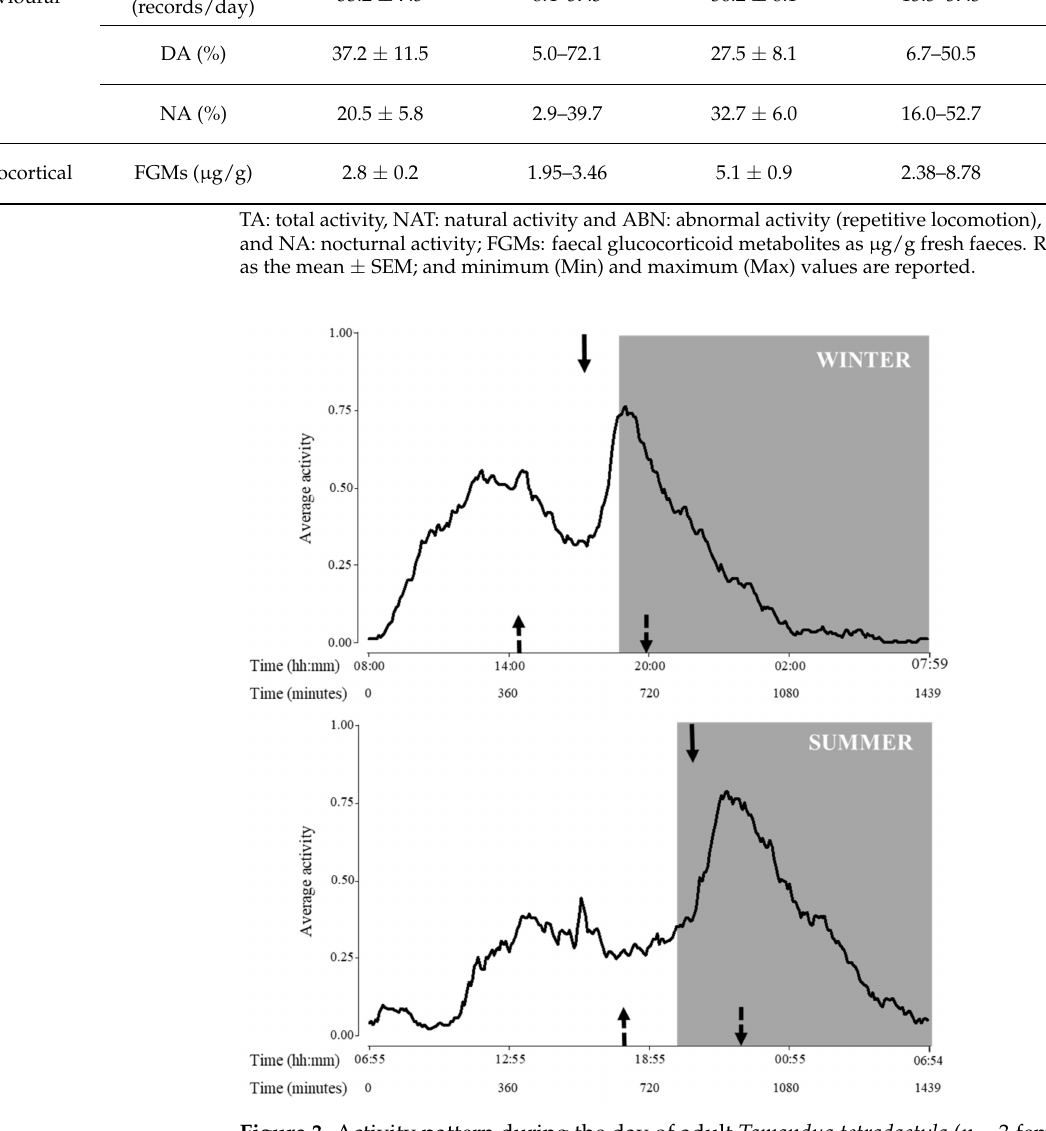
Figure 3. Activity pattern during the day of adult Tamandua tetradactyla ( n = 3 females and 3 males) exposed to semi-controlled conditions, during winter (upper panel) and summer (lower panel). Behaviour was recorded every 5 min (288 records/day/individual) during 29 consecutive days for each season, and the average activity was calculated. Arrows represent activity cycle variables during each season (top arrow: acrophase, upward-pointing dotted arrow: beginning of activity, and downward-pointing dotted arrow: end of activity). Significant differences were found ( p values in the text). Light phase: white background; dark phase: grey background. Beginning of X axis corresponds to sunrise for each season due to natural photoperiodic variations. Time is expressed both in hours and minutes and in minutes since